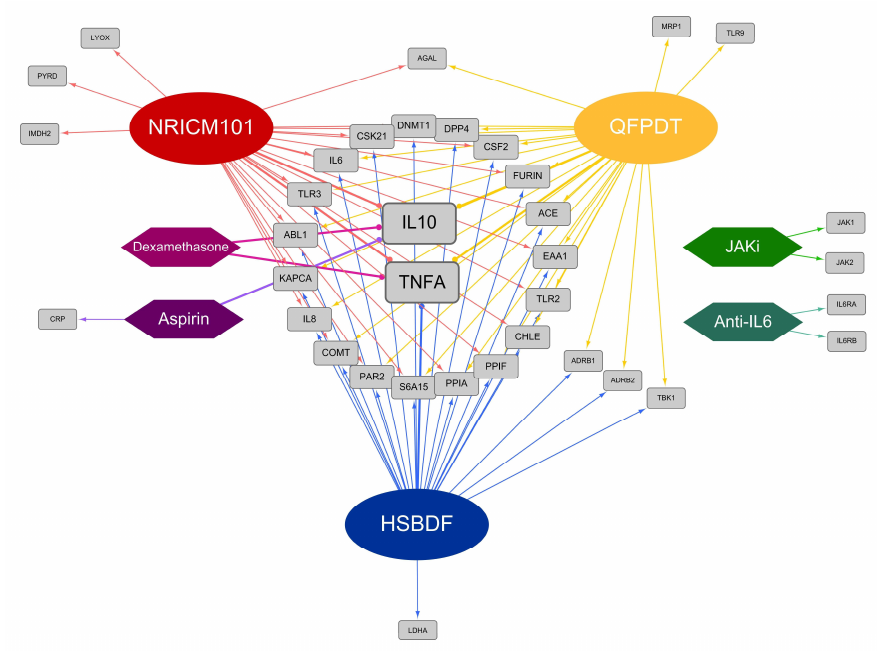
Figure 3. Target–drug interaction network of COVID-related protein in 3 CHM formulas and 6 WM categories.